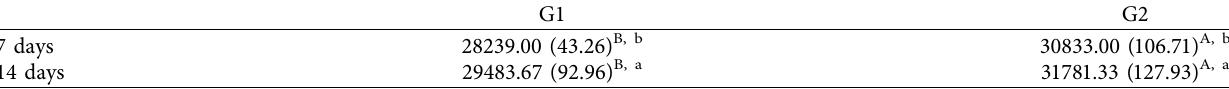
Different capital letters represent differences between groups at each time (horizontal). Different lowercase letters represent differences between times in each group (vertical). Significance level 5%. Group 1 (G1), xenograft associated with peripheral blood; Group 2 (G2), xenograft associated with mandibular bone marrow blood